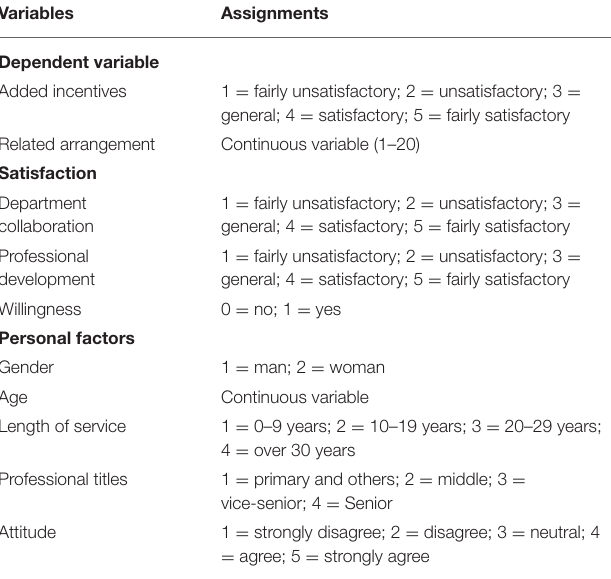
TABLE 1 | Dependent variables and